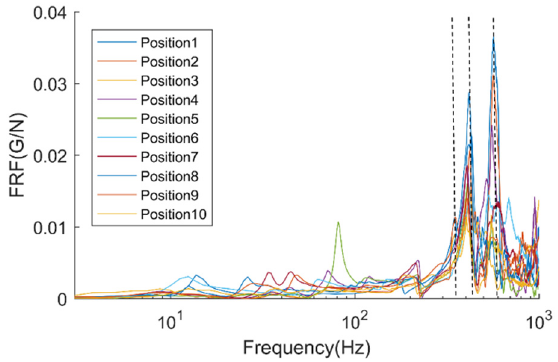
Figure 1. Frequency Response Functions of different robot configurations.